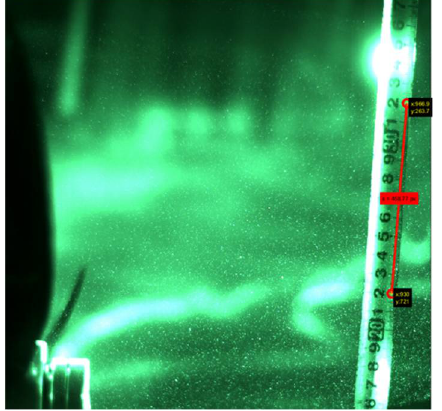
Figure 8. PIV experiment calibration frame.